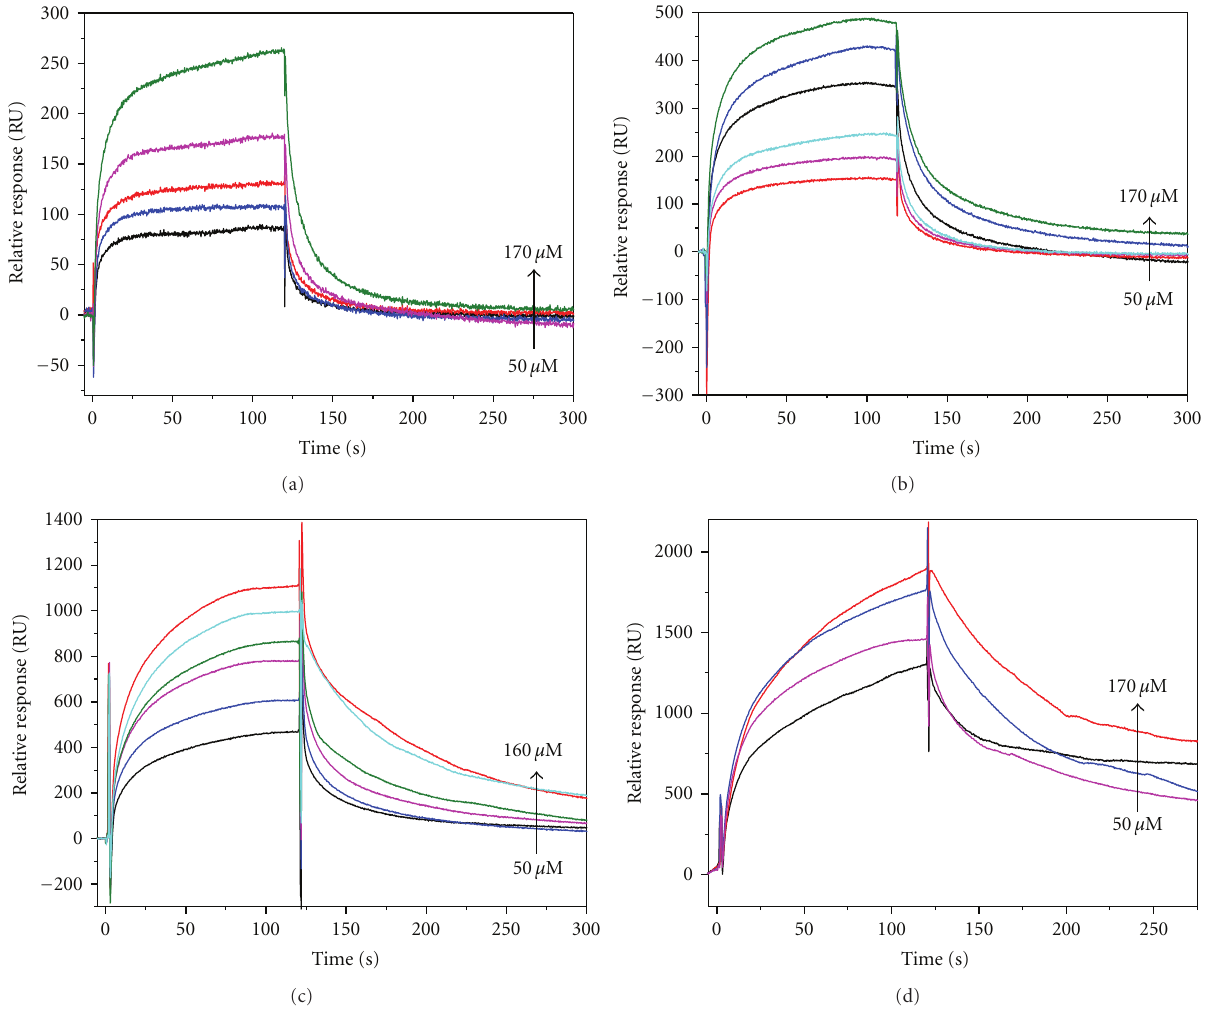
Figure 2: Representative SPR sensorgram responses for CLP-A (50–200 μ M) binding to HSA at (a) 20 ◦ C, (b) 25 ◦ C, (c) 30 ◦ C, (d) 37 ◦ C. Experiments performed at each temperature were independent experiments and each experiment was